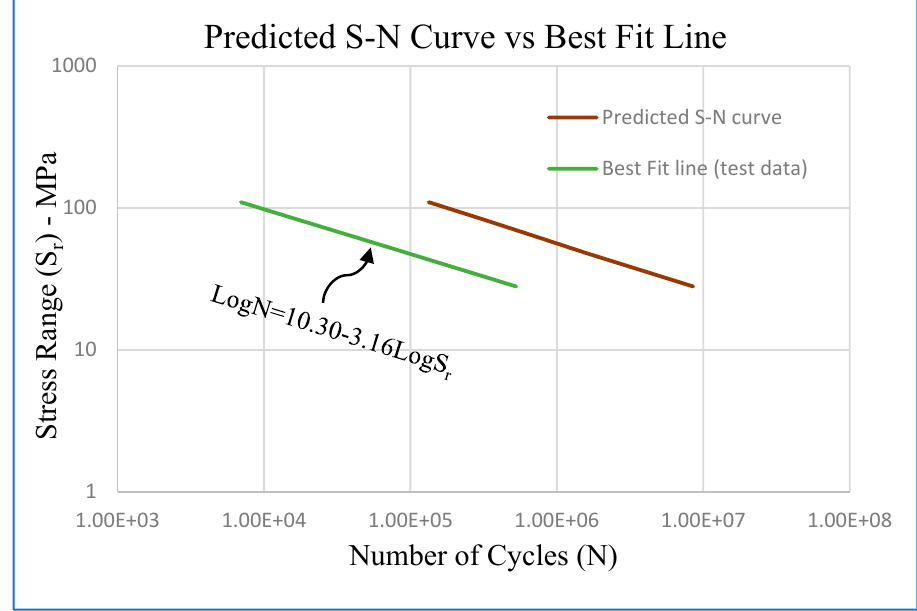
Figure 16. Predicted S-N curve vs best fit line.